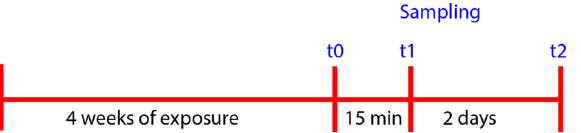
Figure 7. Timeline of experiment and samplings; t0: 28 days after start of experiment; t1: 15 min after the stressor (netting and 30-s air-exposure); t2: two days after first